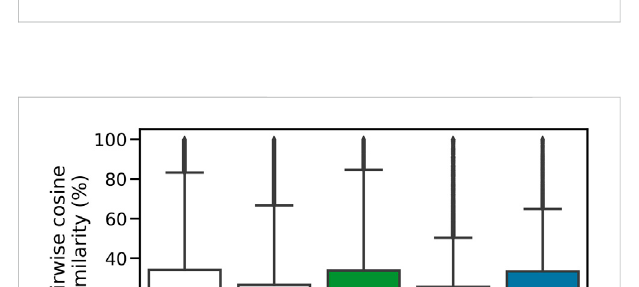
FIGURE 6 Proportion of matched features to the total number of detected features from the fullscan data.